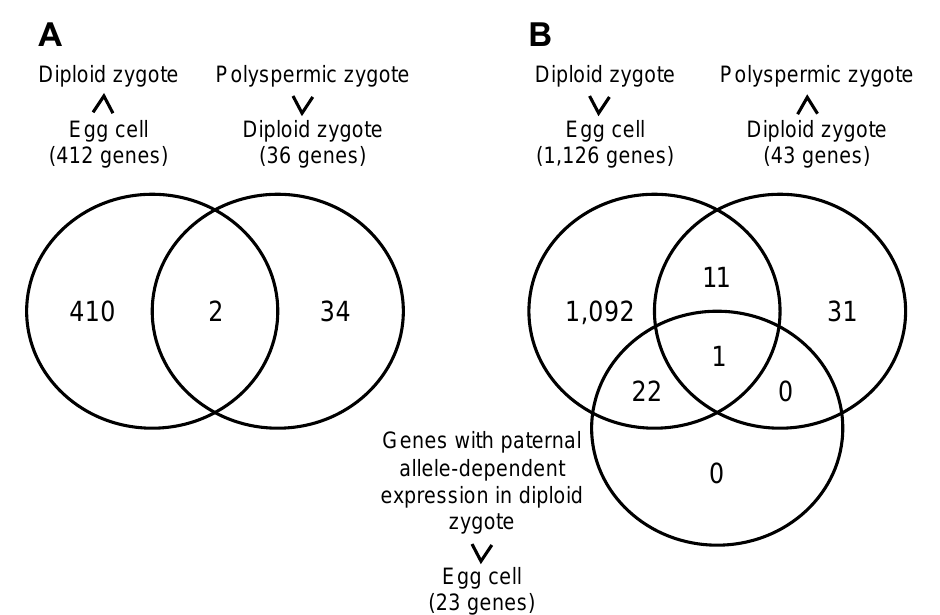
Figure 5. Gene expression in rice polyspermic zygotes and diploid zygotes. ( A ) Venn diagram of 412 genes, whose expression levels in diploid zygotes are suppressed after fertilization [29], and 36 genes, whose expressions are up-regulated in polyspermic zygotes relative to diploid zygotes (Table 2). ( B ) Venn diagram of 1,126 genes, which were detected as fertilization-induced genes in rice diploid zygotes [29], 43 genes, whose expressions are down-regulated in polyspermic zygotes relative to diploid zygotes (Table 3), and 23 genes which are up-regulated in diploid zygotes after fertilization with paternal allele dependent expression [29].